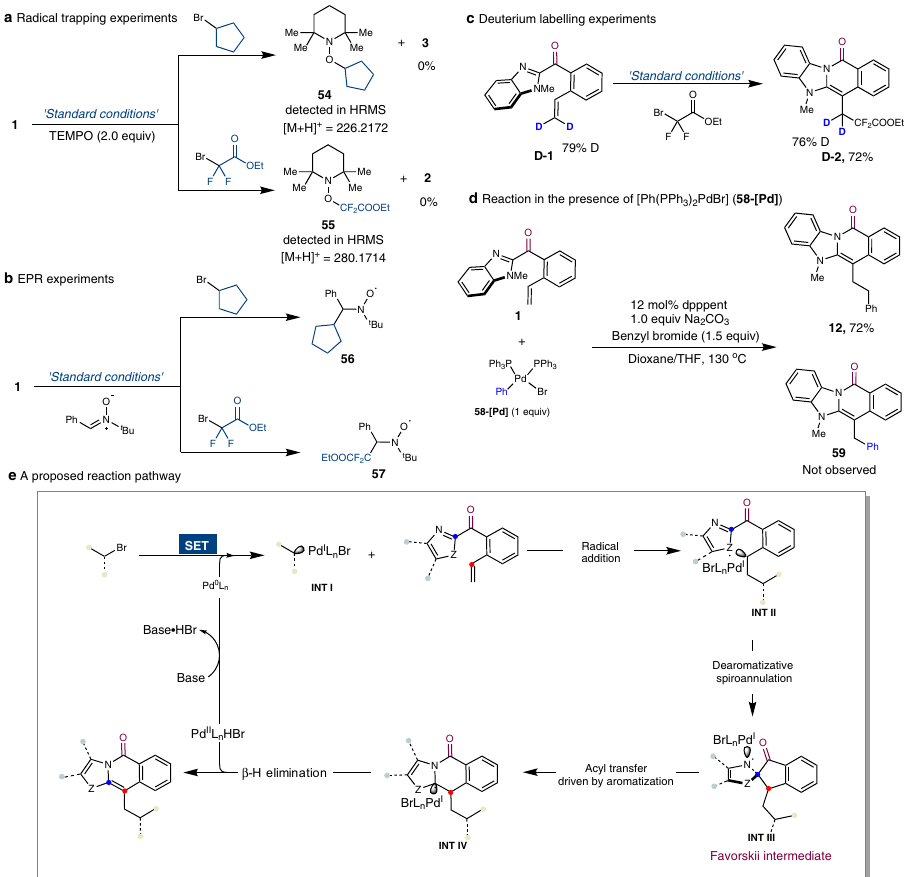
Fig. 4 Mechanistic studies. a Radical trapping study using TEMPO showing that alkyl radical species are involved in the reaction. b EPR studies also suggest that this reaction may involve alkyl radicals. c Deuterium labelling studies. d Reaction of 1 with benzyl bromide in the presence of [Ph(PPh 3 ) 2 PdBr] ( 58-[Pd] ). e A proposed reaction